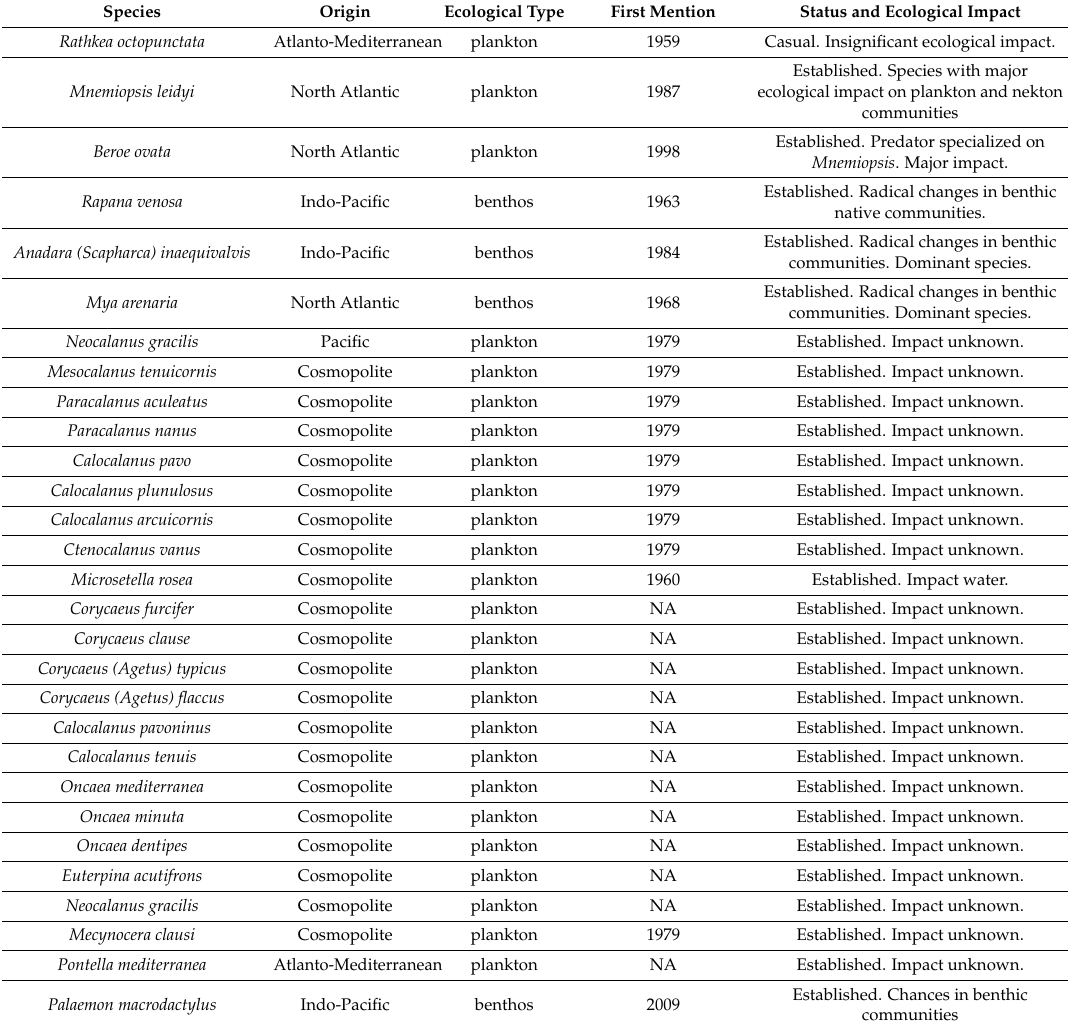
Table 2. Selection of alien invasive species in the Black